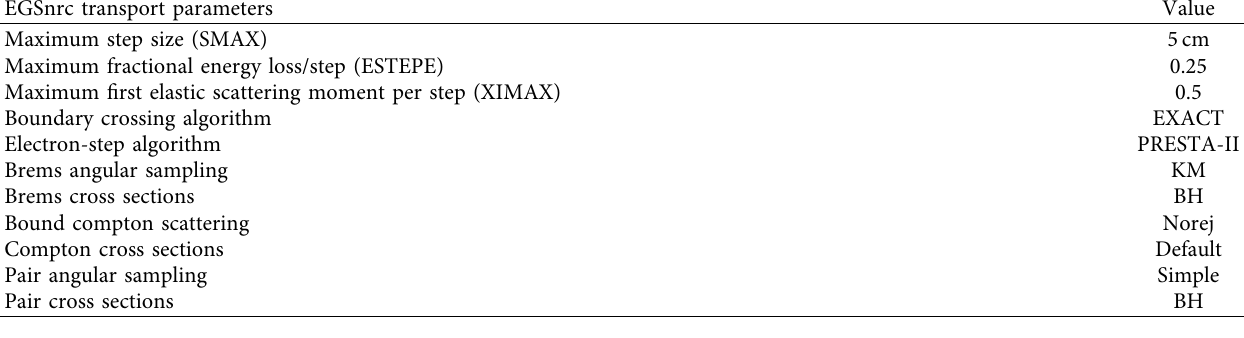
Table 1: The main EGSnrc transport parameters used in this study.